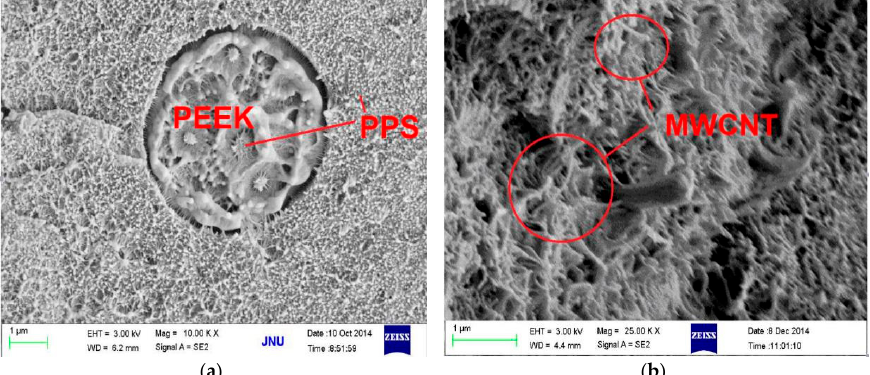
Figure 5. SEM micrographs of PPS/PEEK/MWCNT composites filled with 0.5 wt % MWCNT